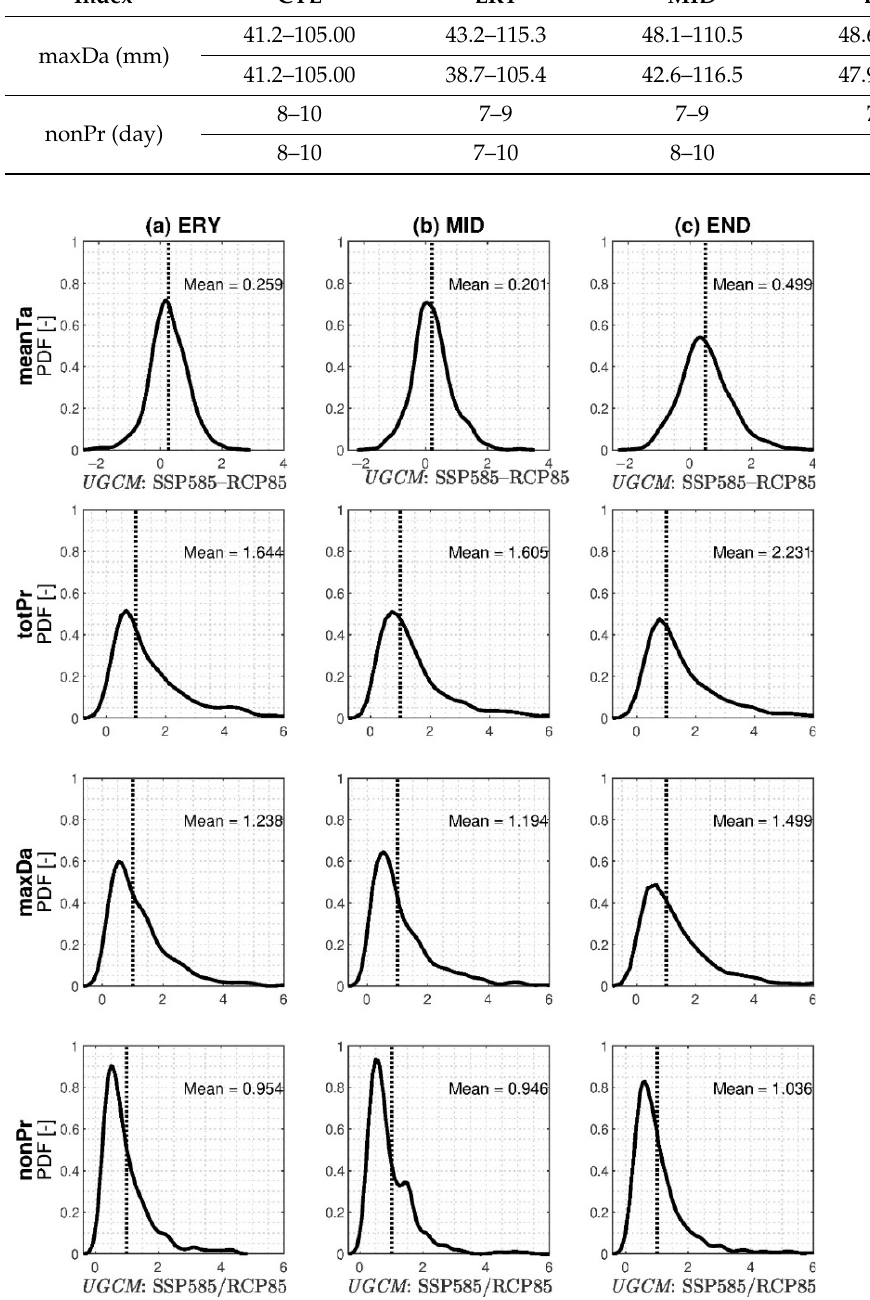
Figure 7. Non-parametric kernel distributions for the ratio of the UGCM values between the emission scenario SSP5-8.5 of CMIP6 and RCP 8.5 of CMIP5: ( a ) ERY, ( b ) MID, and ( c ) END. Each row plots correspond to indices of meanTa, totPr, maxDa, and nonPr, respectively. The number of data points for establishing the distribution is 520 (40 locations × 13 (12 months + year)).